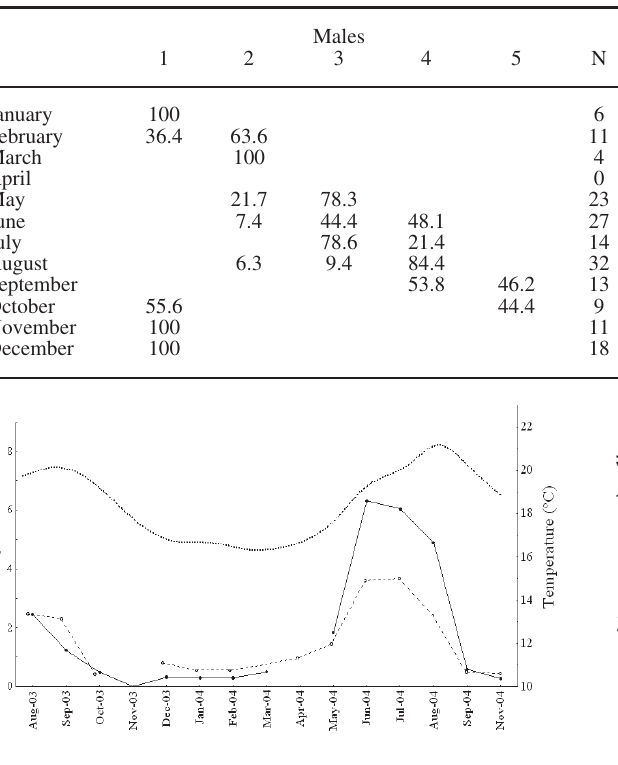
Fig . 4. – monthly evolution (mean ± sd) of the gonadossomatic maturity index ( I ) for mature male (solid line) and female (dashed g line) white trevally caught in the Azores; variation of mean monthly temperature (at 28 m depth) is also shown (dotted line).